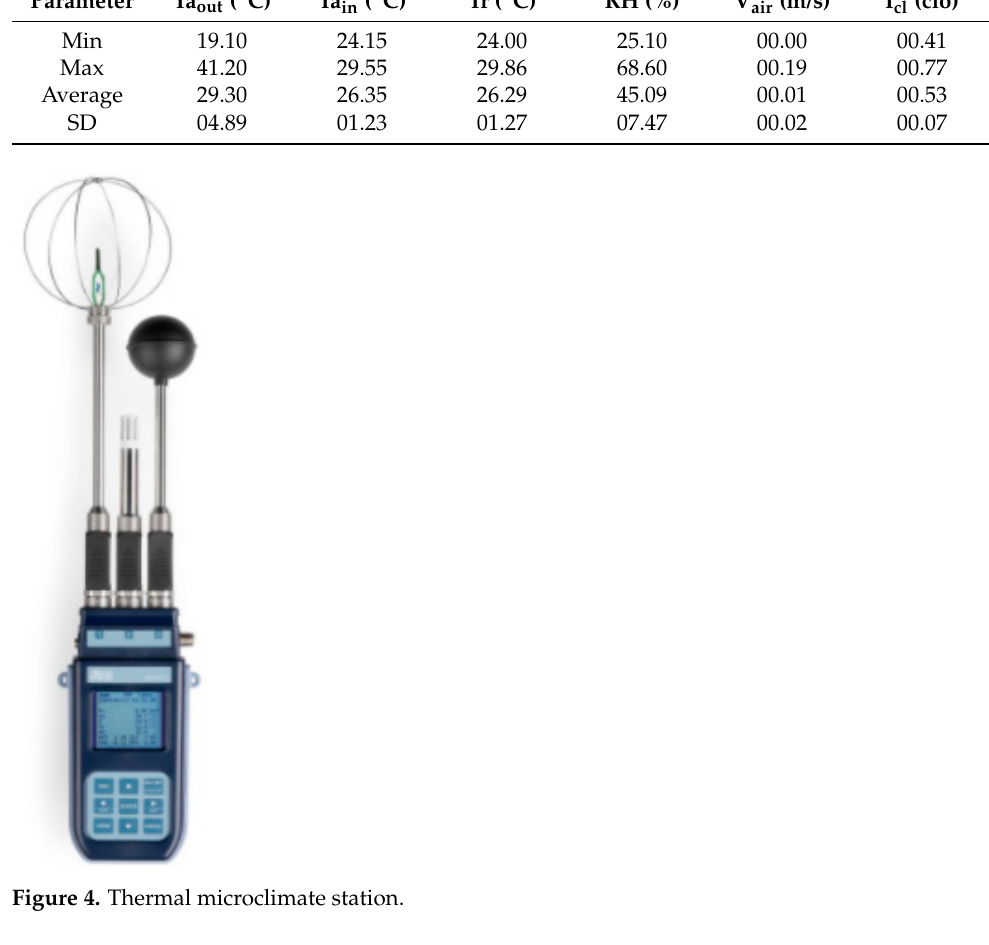
Figure 5. Subjective ruler for measuring thermal sensations.